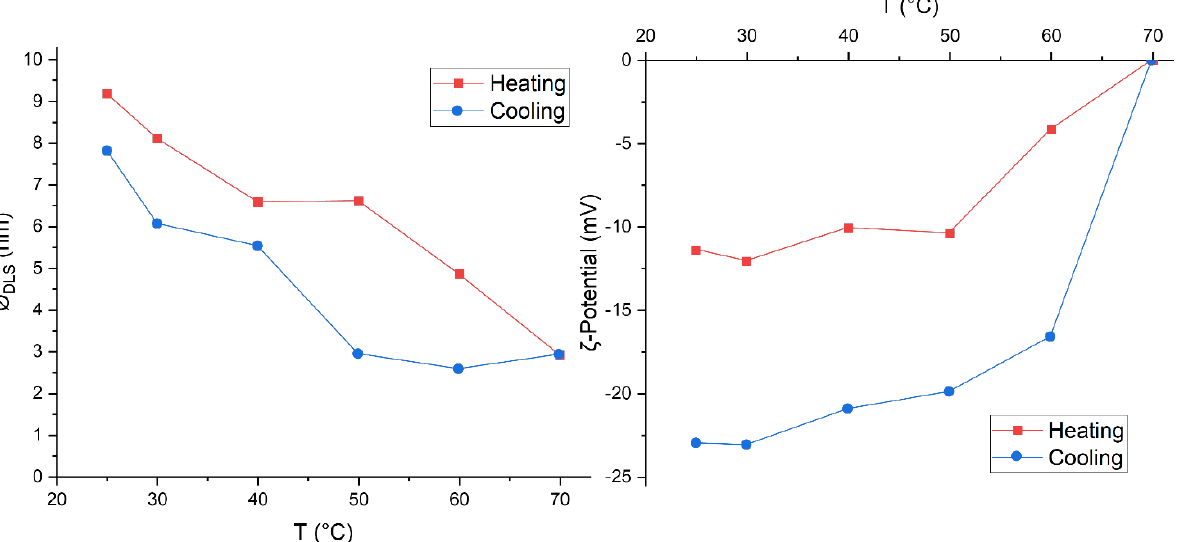
Figure 8. Effect of temperature on DLS diameter ( left ) and ζ -Potential measured via ELS ( right ) of Au-PVA_99 colloidal suspension during heating (red curves) and cooling (blue curves).